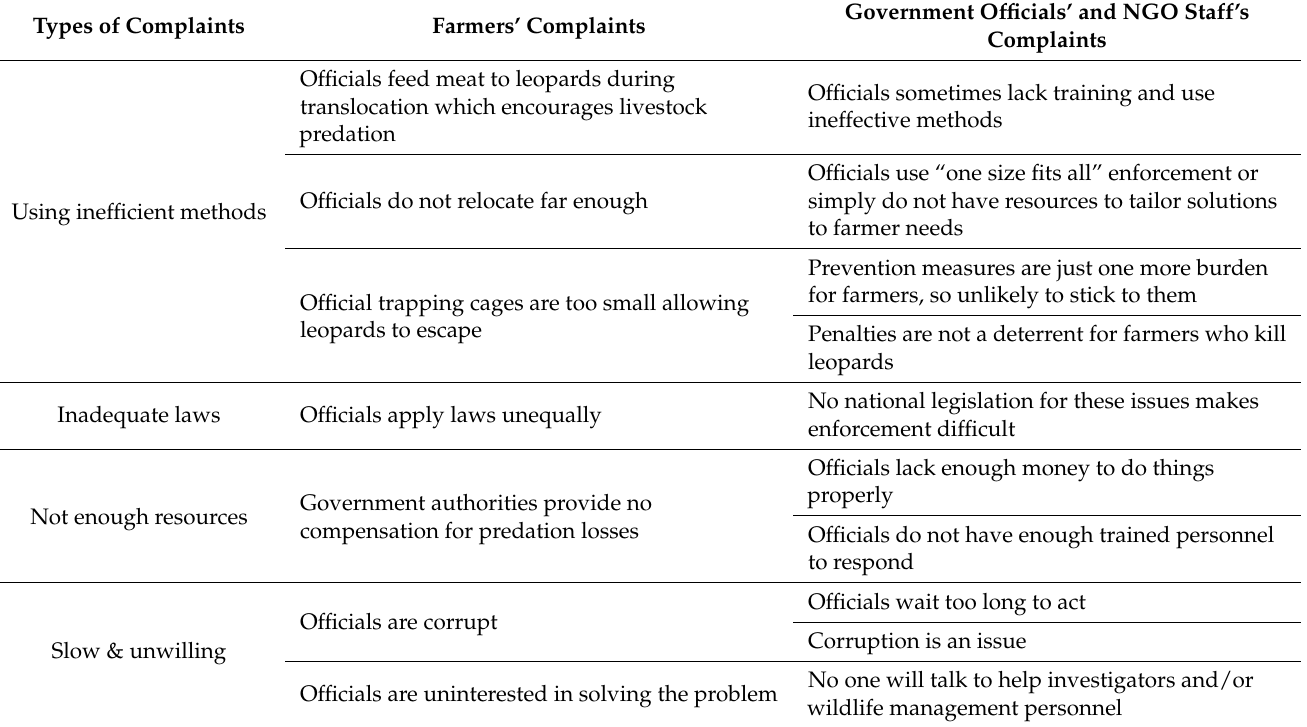
Table 2. Respondents’ complaints about the official response to leopard predation and retaliatory killings. Types of